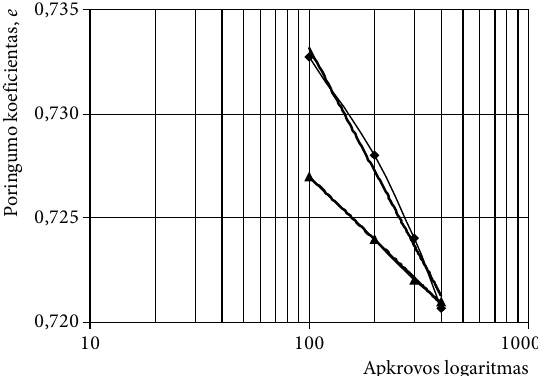
Fig. 11. Void ratio versus logarithm of load